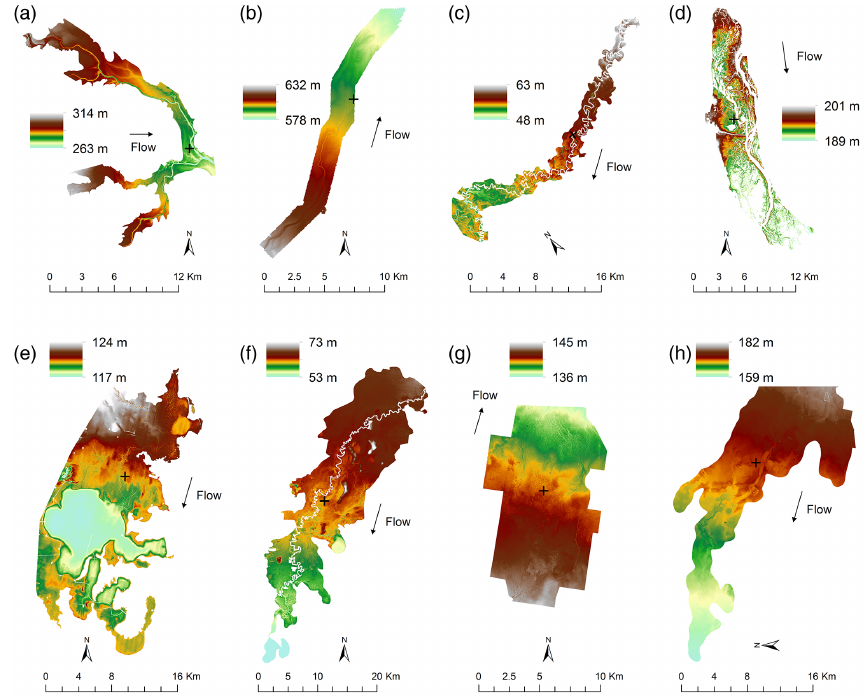
Figure 1. Digital elevation models displaying the floodplain surface in metres above sea level for each study site (crosses indicate coor- dinates listed): (a) Shingwedzi (31 ◦ 24 (cid:48) E, 23 ◦ 05 (cid:48) S), (b) Woodforde (133 ◦ 20 (cid:48) E, 22 ◦ 21 (cid:48) S), (c) Bidgee (143 ◦ 24 (cid:48) E, 34 ◦ 42 (cid:48) S), (d) Missis- sippi (91 ◦ 15 (cid:48) W, 43 ◦ 29 (cid:48) N), (e) Narran (147 ◦ 23 (cid:48) E, 29 ◦ 48 (cid:48) S), (f) Yanga (143 ◦ 42 (cid:48) E, 34 ◦ 30 (cid:48) S), (g) Macquarie (147 ◦ 33 (cid:48) E, 30 ◦ 41 (cid:48) S), and (h) Gwydir (149 ◦ 20 (cid:48) E, 29 ◦ 16 (cid:48)